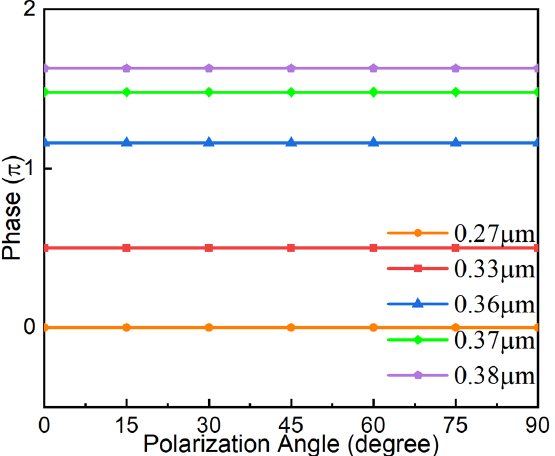
Figure 5. The veri fi cation of the polarization-maintaining performance of the nanocolumn.